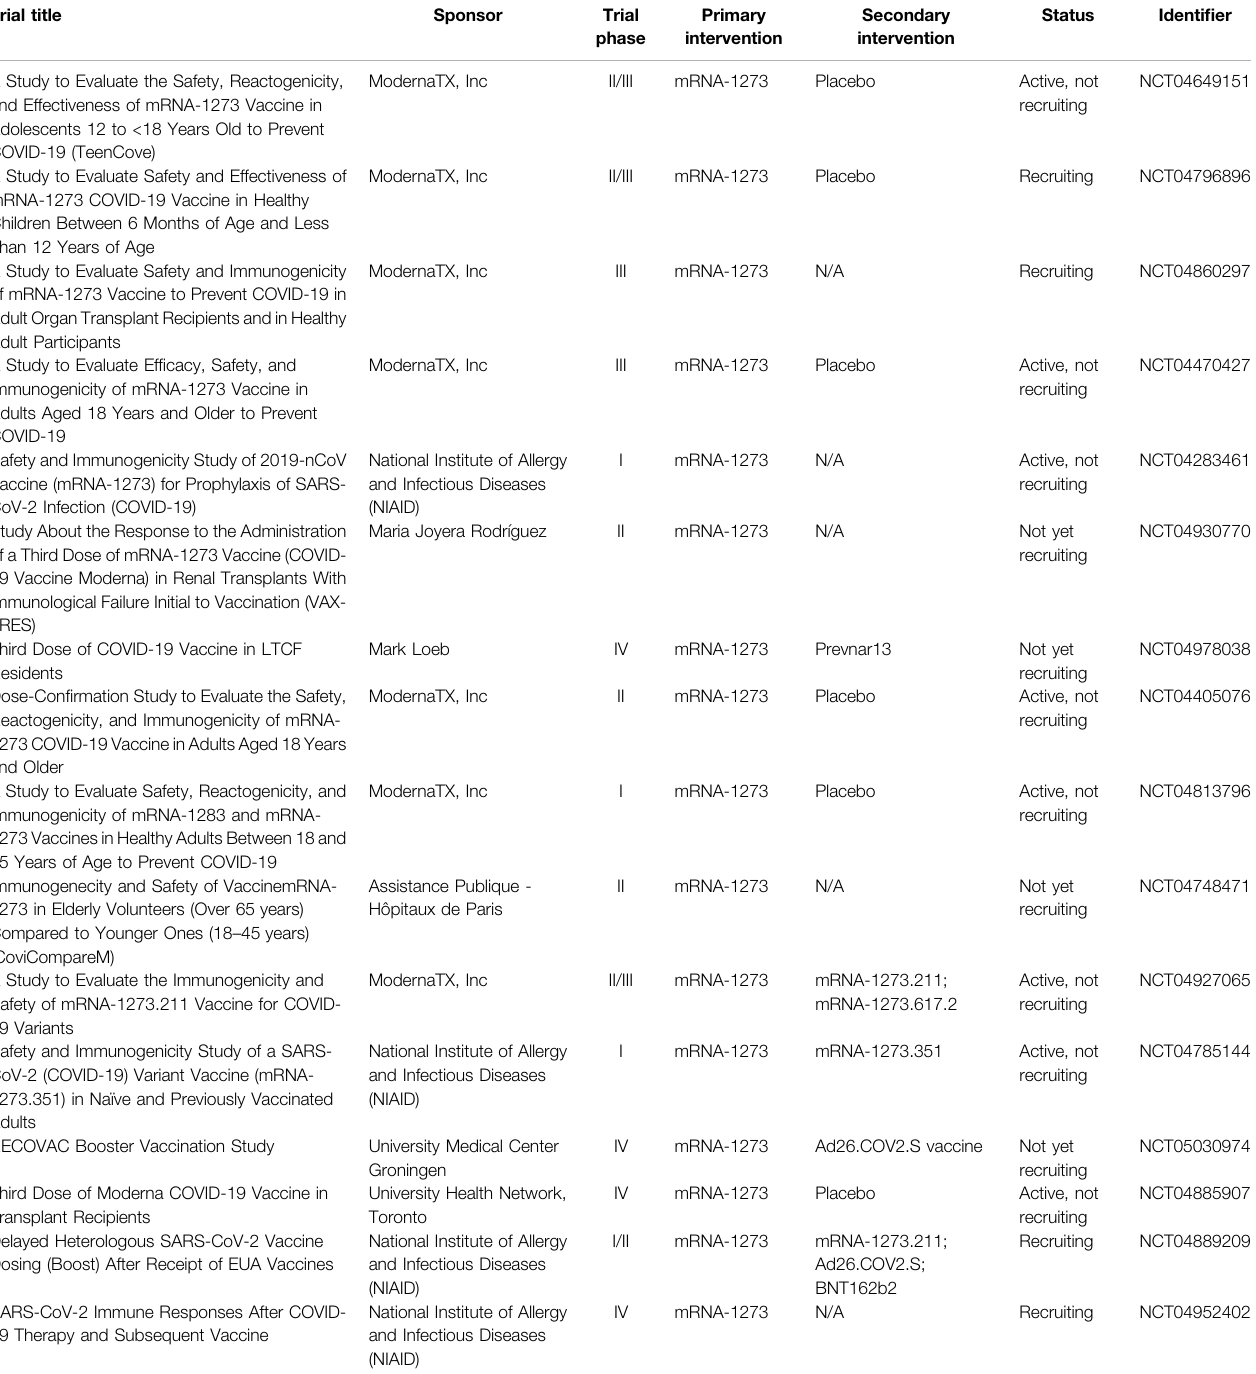
TABLE 11 | Summary of clinical trials of mRNA-1273 vaccine (produced by Moderna) on COVID-19